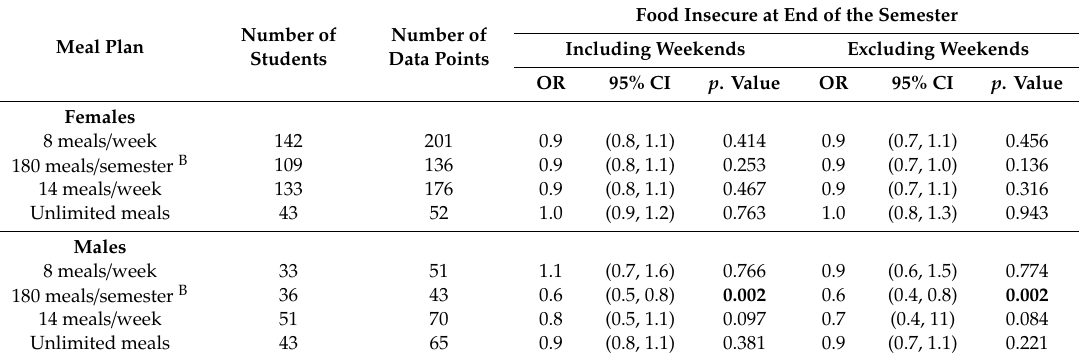
Table 5. Results of the logistic generalized estimating equation (GEE) determining if food insecurity at the end of the semester is associated with number of meals used A after stratifying by gender and meal